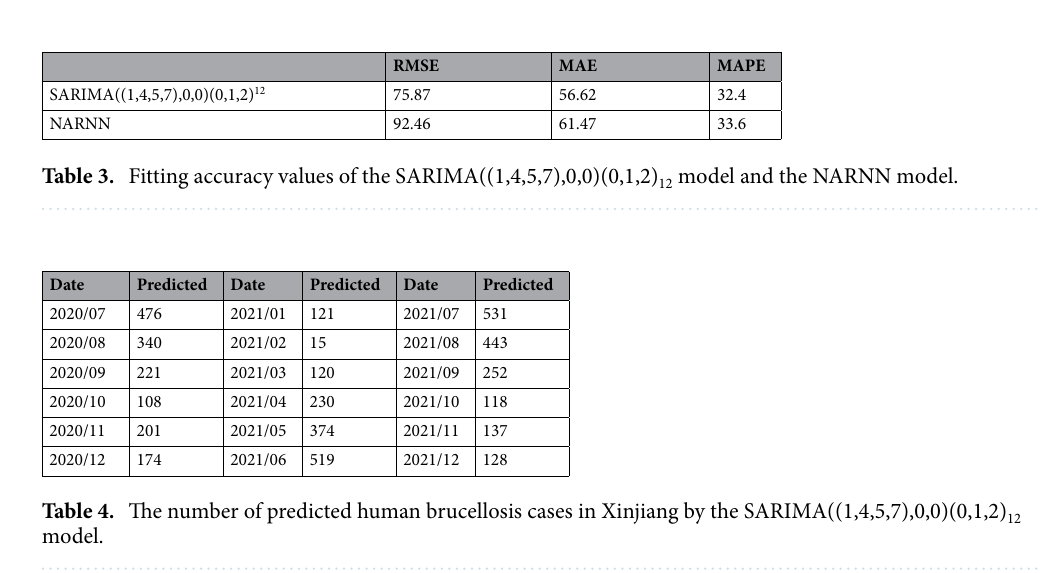
SARIMA((1,4,5,7),0,0)(0,1,2) 12